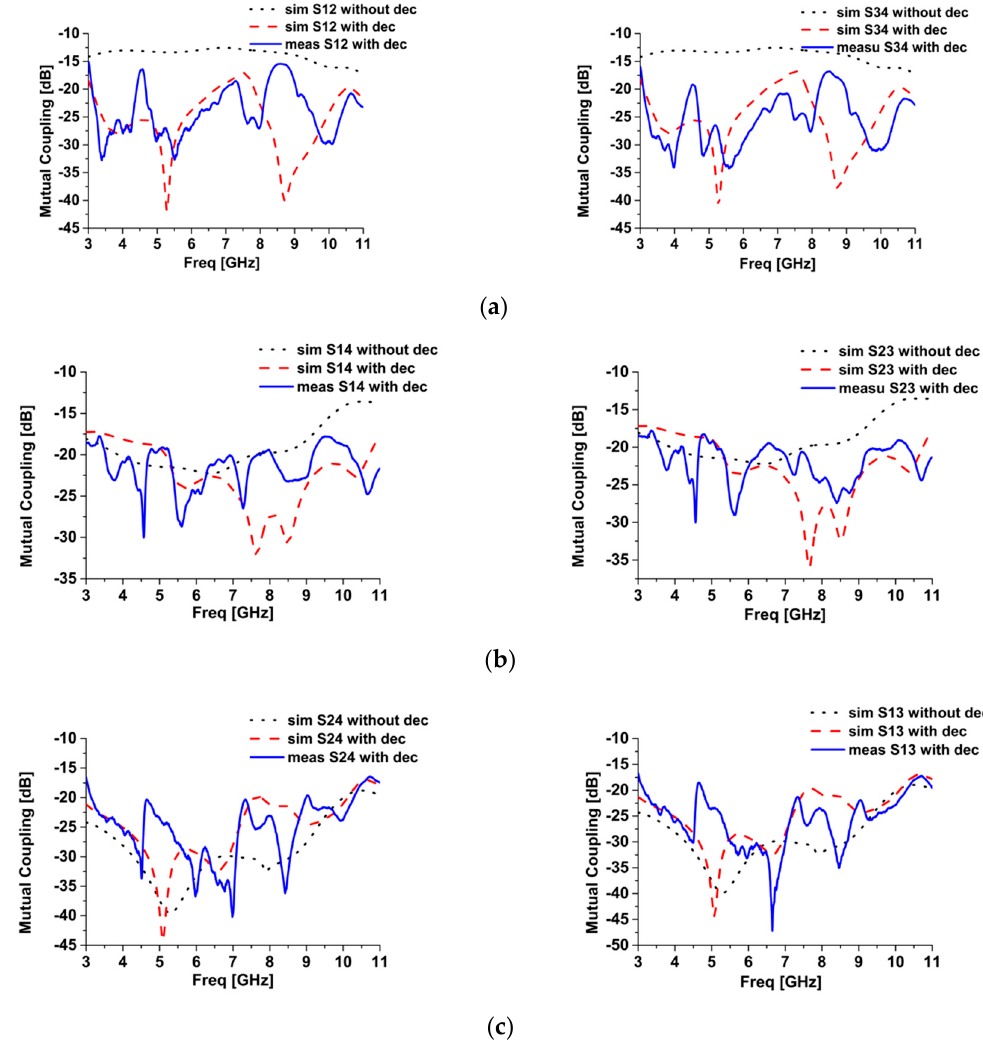
Figure 7. Mutual coupling reduction among antenna elements: ( a ) side-by-side antennas; ( b ) across antennas; ( c ) diagonally-across antennas.